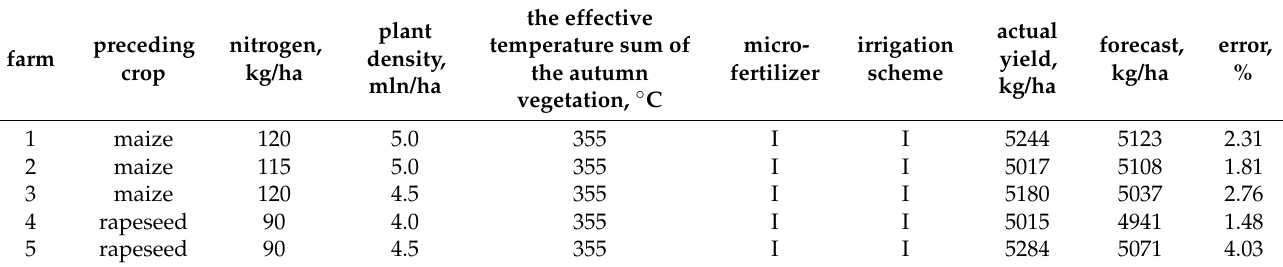
Table 10. Predicting for